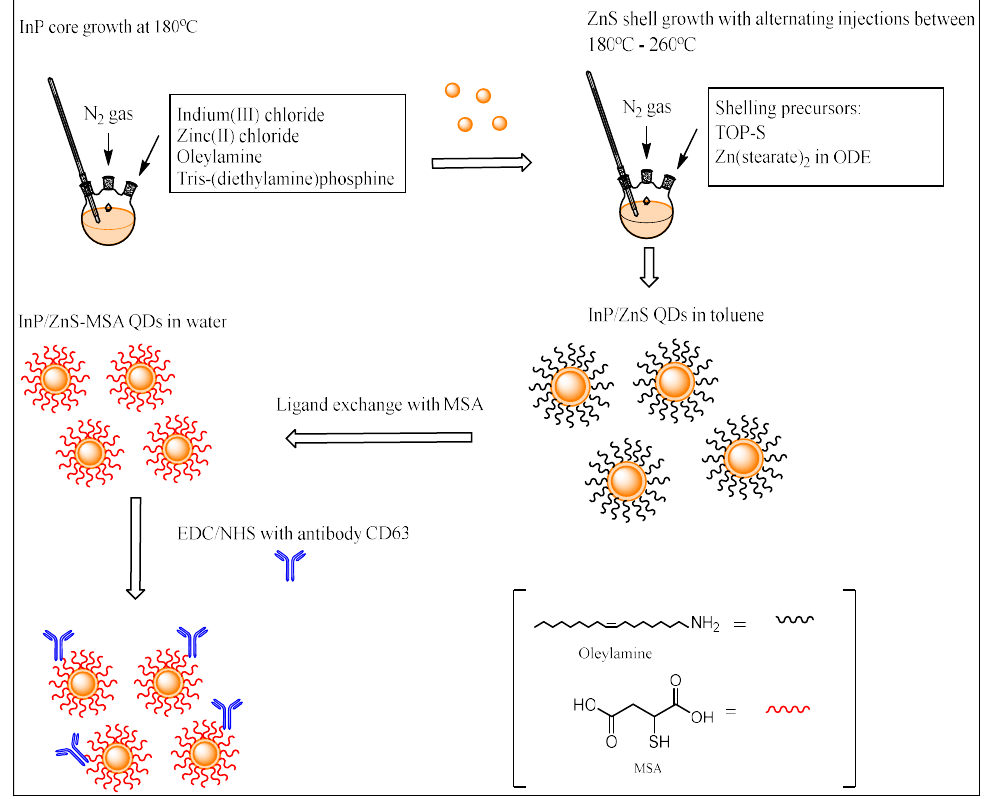
Figure 1. Synthetic scheme for the InP/ZnS quantum dots (QDs) conjugated to the antibody anti-CD63.